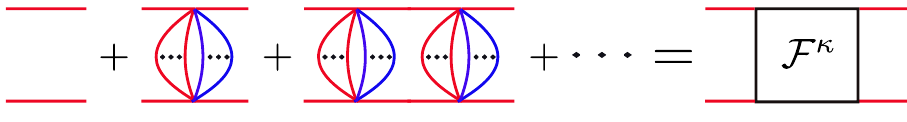
Figure 5 . Simplest \melonic" contribution to (cid:20) four point function in large N